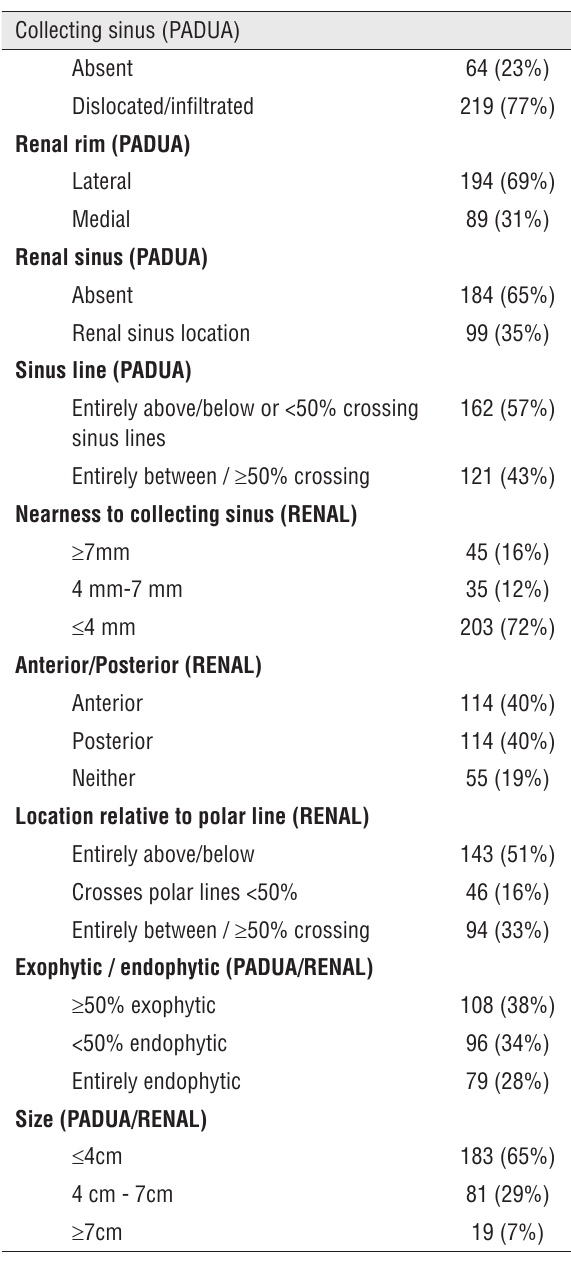
Table 2 - REnAL and pADuA subscale scores, n=283. Data are reported as frequency